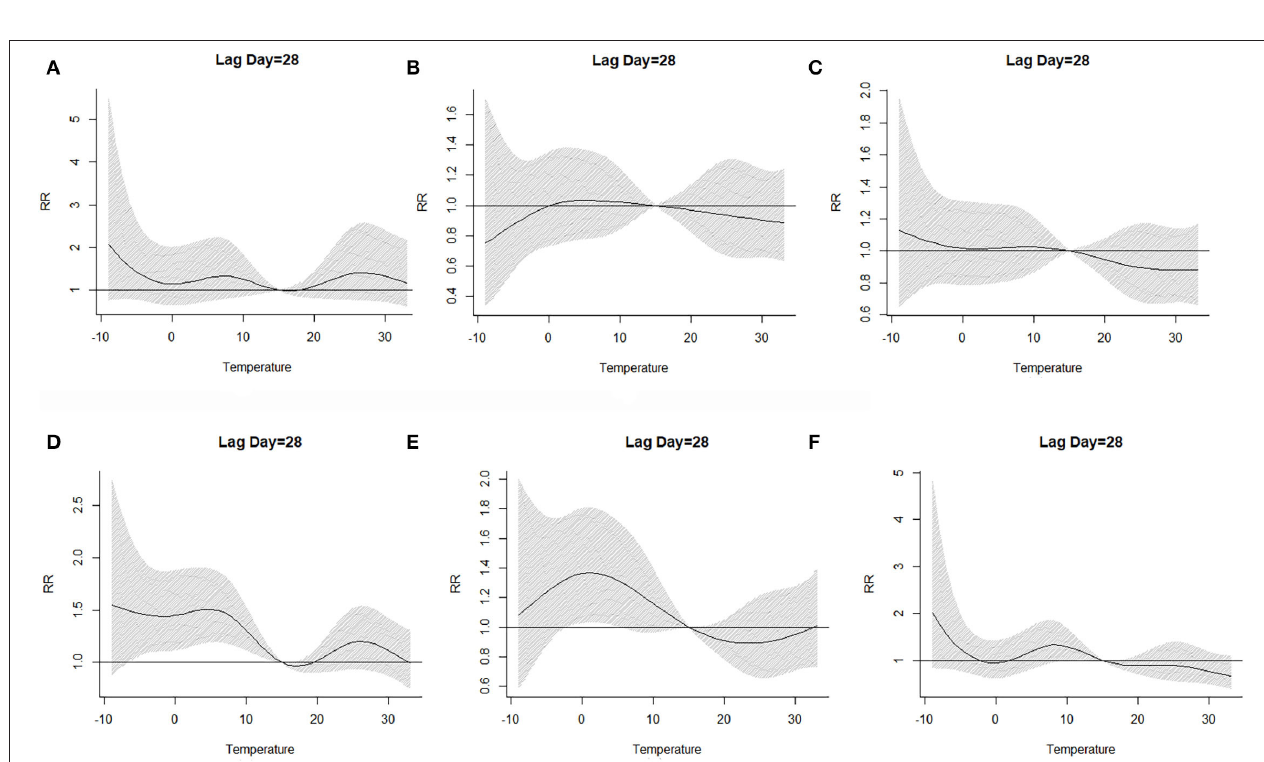
FIGURE 8 | The effect of temperature on the hospitalization when lag day was on 28 [ (A) age ≤ 30 group; (B) 30 < age ≤ 40 group; (C) 40 < age ≤ 50; (D) 50 < age ≤ 60; (E) 60 < age ≤ 70; (F) age > 70].